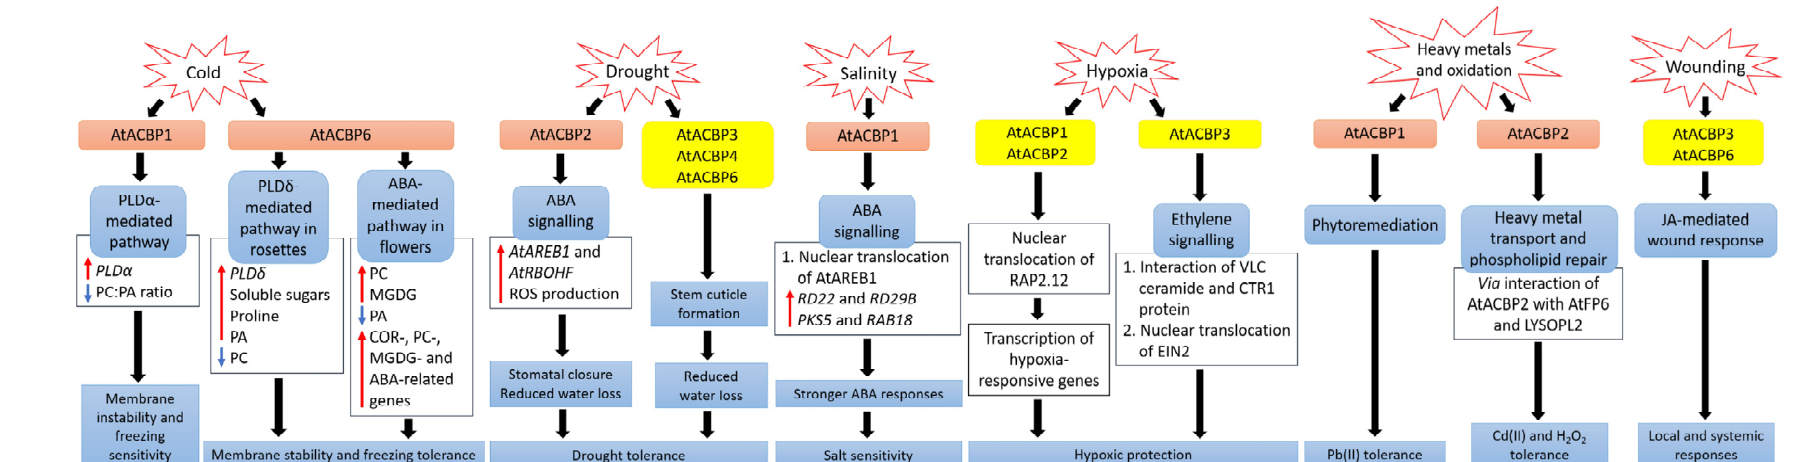
Figure 1. Signalling pathways associated with acyl-CoA-binding proteins (ACBPs) following abiotic stresses in Arabidopsis thaliana . In transgenic Arabidopsis Class II AtACBP1- overexpressors (OEs), PLD α 1 was induced upon cold stress, causing a decrease in the ratio of PC to PA leading to membrane instability and freezing sensitivity [88]. In contrast, transgenic Arabidopsis Class I AtACBP6-OEs were conferred freezing tolerance via the PLD δ -mediated pathway in rosettes and the ABA-mediated pathway in flowers, resulting in changes in lipids, sugars and stress-related genes [87,123]. During drought, transgenic Arabidopsis Class II AtACBP2-OEs exhibited elevated AtAREB1 and AtRBOHF expression which led to ROS production, subsequent stomatal closure and reduced water loss [90]. Proper stem cuticle development conferred by Class I AtACBP6, Class III AtACBP3 or Class IV AtACBP4 protects wild-type Arabidopsis from water loss [25]. Under high salinity, AtACBP1 and AtAREB1 expression were upregulated in wild-type seeds [80]. The overexpression of AtACBP1 in transgenic Arabidopsis triggers nuclear translocation of AtAREB1, leading to the induction of stress marker genes ( RD22 and RD29B ) and AtAREB1 target genes ( PKS5 and RAB18 ), thereby promoting stronger ABA responses during seed germination and seedling establishment [80]. When wild-type Arabidopsis undergoes hypoxia, the RAP2.12 transcription factor bound to AtACBP1 or AtACBP2, translocates to the nucleus and activates hypoxia-responsive gene transcription, conferring hypoxic protection [77,128,134,139]. Another hypoxic tolerance pathway involves the interaction of unsaturated VLC ceramide and the CTR1 protein with subsequent nuclear translocation of EIN2, resulting in the activation of CTR1-mediated ethylene signalling [137]. AtACBP1 is involved in phytoremediation and its overexpression in transgenic Arabidopsis confers Pb(II) tolerance [135]. AtACBP2 can interact with AtFP6 or LYSOPL2, mediating heavy metal transport and phospholipid repair respectively, and hence transgenic Arabidopsis AtACBP2-OEs were resistant to Cd(II) and Cd(II)-induced oxidative stress [75,76,82]. On wounding, the up-regulation of AtACBP3 and AtACBP6 expression in the wild type suggested their involvement in JA-mediated local and systemic wound responses [125,126]. Orange and yellow boxes indicate transgenic Arabidopsis AtACBP-OEs and wild-type Arabidopsis AtACBPs respectively, used in studies on abiotic stress. Blue boxes represent the signalling pathways. White boxes indicate the molecular events that occur along the signalling pathway. Red and blue arrows indicate increase and a decrease, respectively. Black arrows denote the flow of events. ABA, abscisic acid; ACBP, acyl-CoA-binding protein; AREB1, ABA-RESPONSIVE ELEMENT BINDING PROTEIN1; FP6, FARNESYLATED PROTEIN6; COR, COLD-RESPONSIVE; CTR1, CONSTITUTIVE TRIPLE RESPONSE1; EIN2, ETHYLENE-INSENSITIVE2; JA, jasmonic acid; LYSOPL2, LYSOPHOSPHOLIPASE2; MGDG, monogalactosyldiacylglycerol; PA, phosphatidic acid; PC, phosphatidylcholine; PKS5, PROTEIN KINASE SOS2-LIKE5; PLD, PHOSPHOLIPASE D; RAB18, RESPONSIVE TO ABA18; RAP2.12, RELATED TO APETALA2.12; RBOHF, RESPIRATORY BURST OXIDASE HOMOLOG F; RD, RESPONSIVE TO DESSICATION; ROS, reactive oxygen species; VLC,